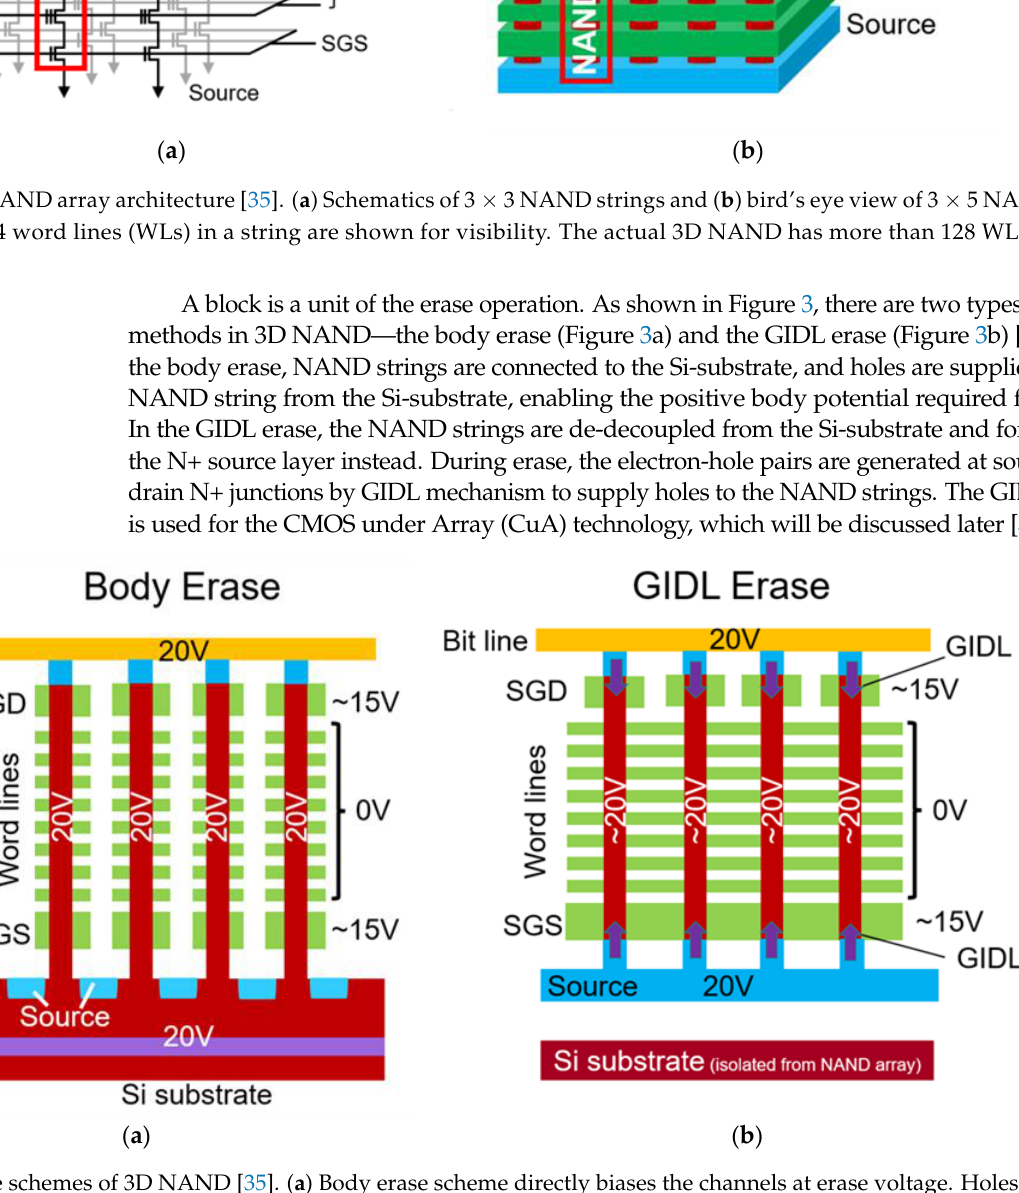
Figure 3. Erase schemes of 3D NAND [35]. ( a ) Body erase scheme directly biases the channels at erase voltage. Holes are supplied from the Si-substrate. ( b ) GIDL erase scheme generates electron-hole pairs at the source and drain junctions. The generated holes are supplied to the channels to boost the potential to around the erase voltage.